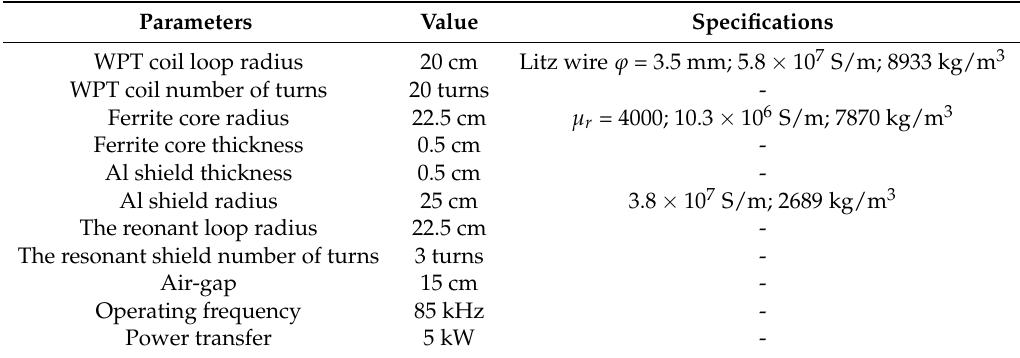
Table 6. The proposed shielding techniques’ design